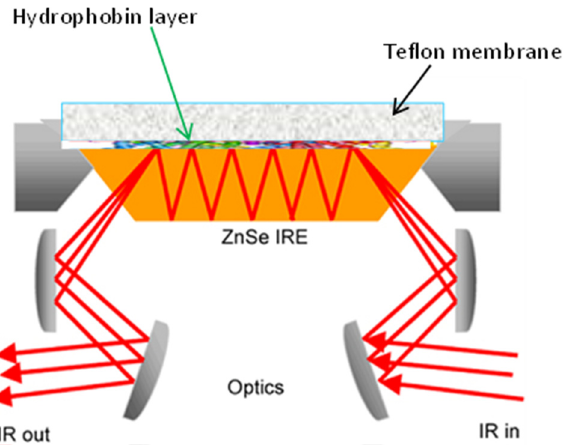
Figure 2. Schematic drawing of the macro ATR-FTIR experimental setup (reprinted with permission from [78]).